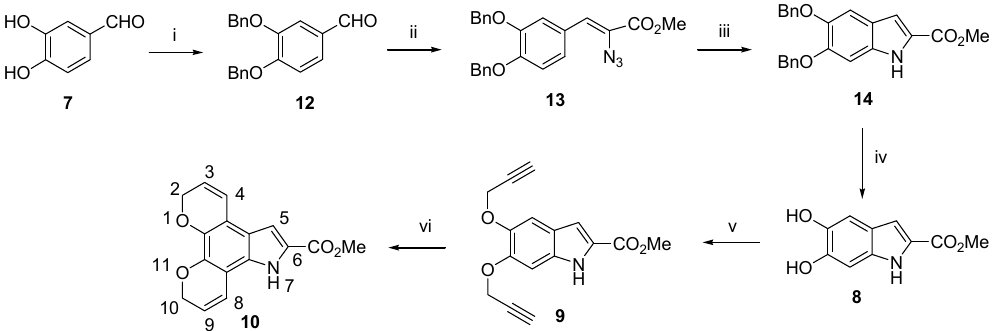
10 Figure 3. Possible reaction mechanism. 2.2. Alternative Pathway for the Preparation of Tetracyclic Dihydropyranoindole 10 (Method 2) The alternative approach began with the reaction of 3,4-dihydroxybenzaldehyde 7 with propargyl bromide under basic conditions (potassium carbonate), which afforded the propargyloxy benzaldehyde 11 [22] in 87% yield. At this point, two synthetic strategies using benzaldehyde 11 as a key intermediate were envisioned (Scheme 2). The first route involved Claisen cyclization to build the dihydropyrano rings 15 , followed by the application of the Hemetsberger indole synthesis to construct the indole scaffold via the unsaturated azido intermediate 16 (Route 1). The cyclization of the aryl ether intermediate 11 was attempted by refluxing in high-boiling solvents such as xylene, toluene, 1,2-dichlorobenzene and chlorobenzene (Scheme 2). In all cases, the novel compound 15 was afforded in low yields, with unreacted starting material being recovered as the major product. The highest yield (35%) was obtained by the use of chlorobenzene. In order to synthesize the desired tetracyclic dihydropyranoindole 10 , the standard Hemetsberger indole synthesis was applied to new intermediate 15 . The condensation of benzaldehyde 15 with methyl azidoacetate was carried out at low temperature (ice-salt bath) in the presence of sodium methoxide. The addition of a small amount of crushed ice to the reaction mixture resulted in the isolation of azido ester 16 as an oily compound which was found to be unstable at room temperature, and was hence used in the next step without further purification. It was postulated that the presence of the dihydropyran ring caused the generation of an unstable azido ester intermediate. Thermal cyclization of the azido ester 16 was performed by heating at reflux in xylene, which afforded the desired dihydropyranoindole 10 in 62%